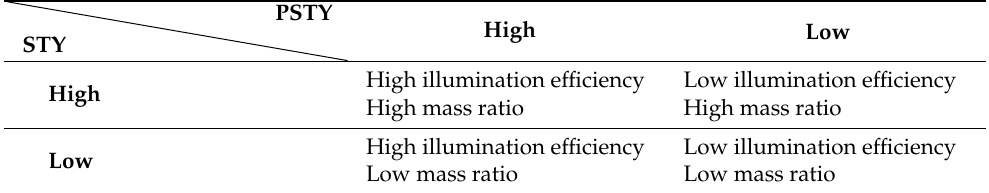
Table 2. Photocatalytic space–time yield (PSTY) vs. space–time yield (STY) (adapted from [50]). PSTY High Low STY High illumination efficiency Low illumination efficiency High High mass ratio High mass ratio High illumination efficiency Low illumination efficiency Low Low mass ratio Low mass